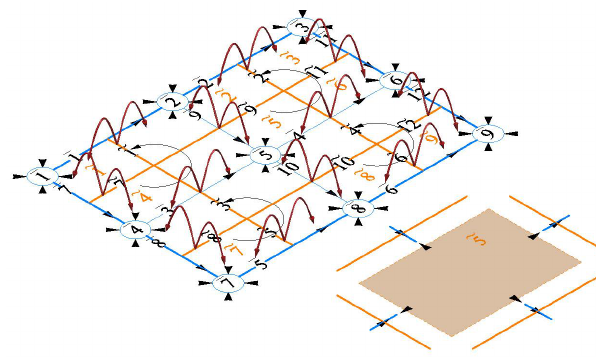
Figure 18: Coboundary process performed on the dual cell